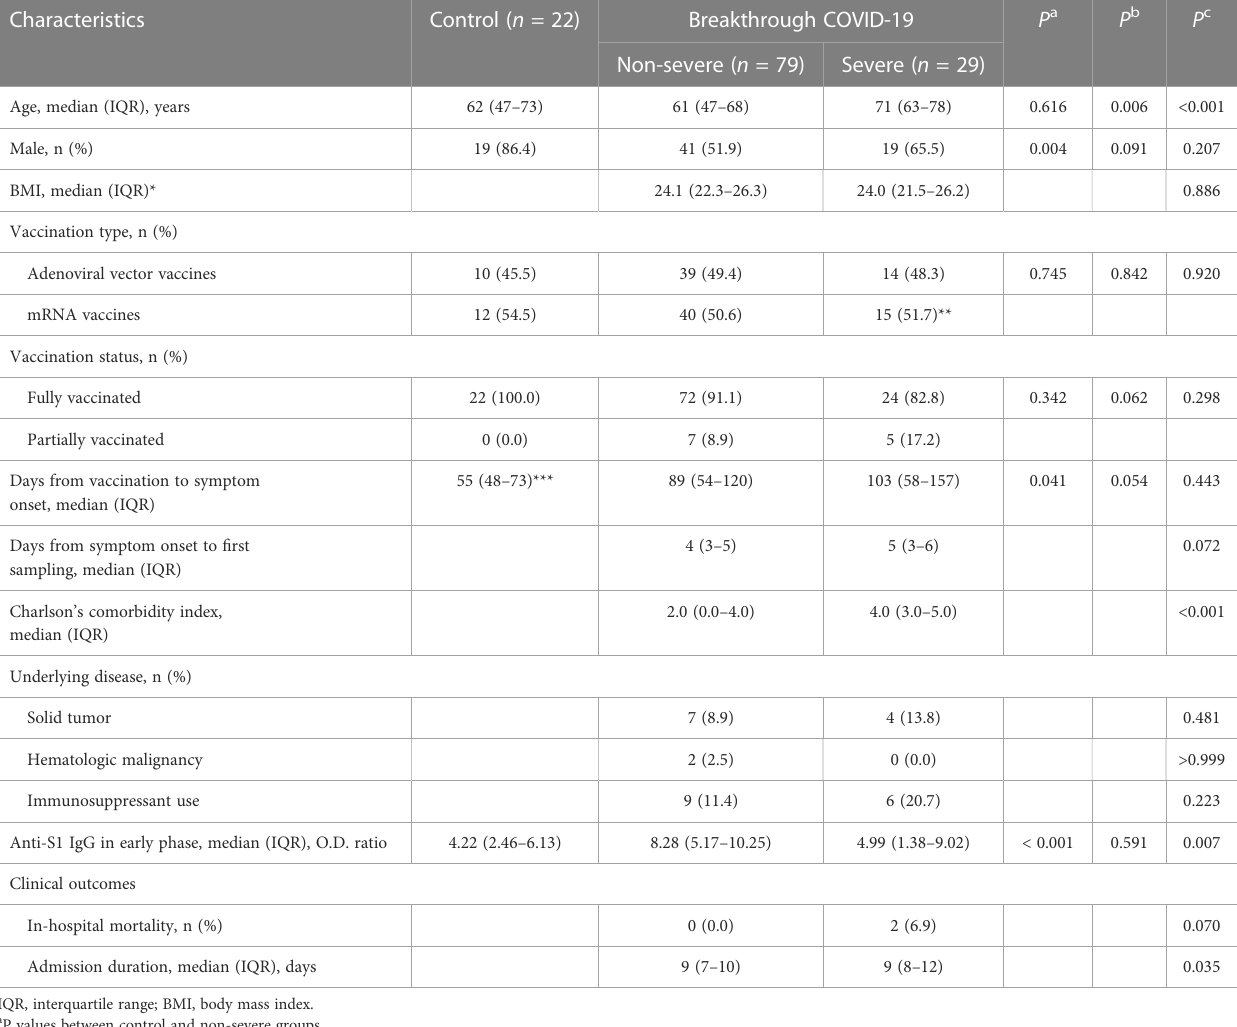
TABLE1 Baseline characteristics and clinical outcomes of patients with breakthrough COVID-19.